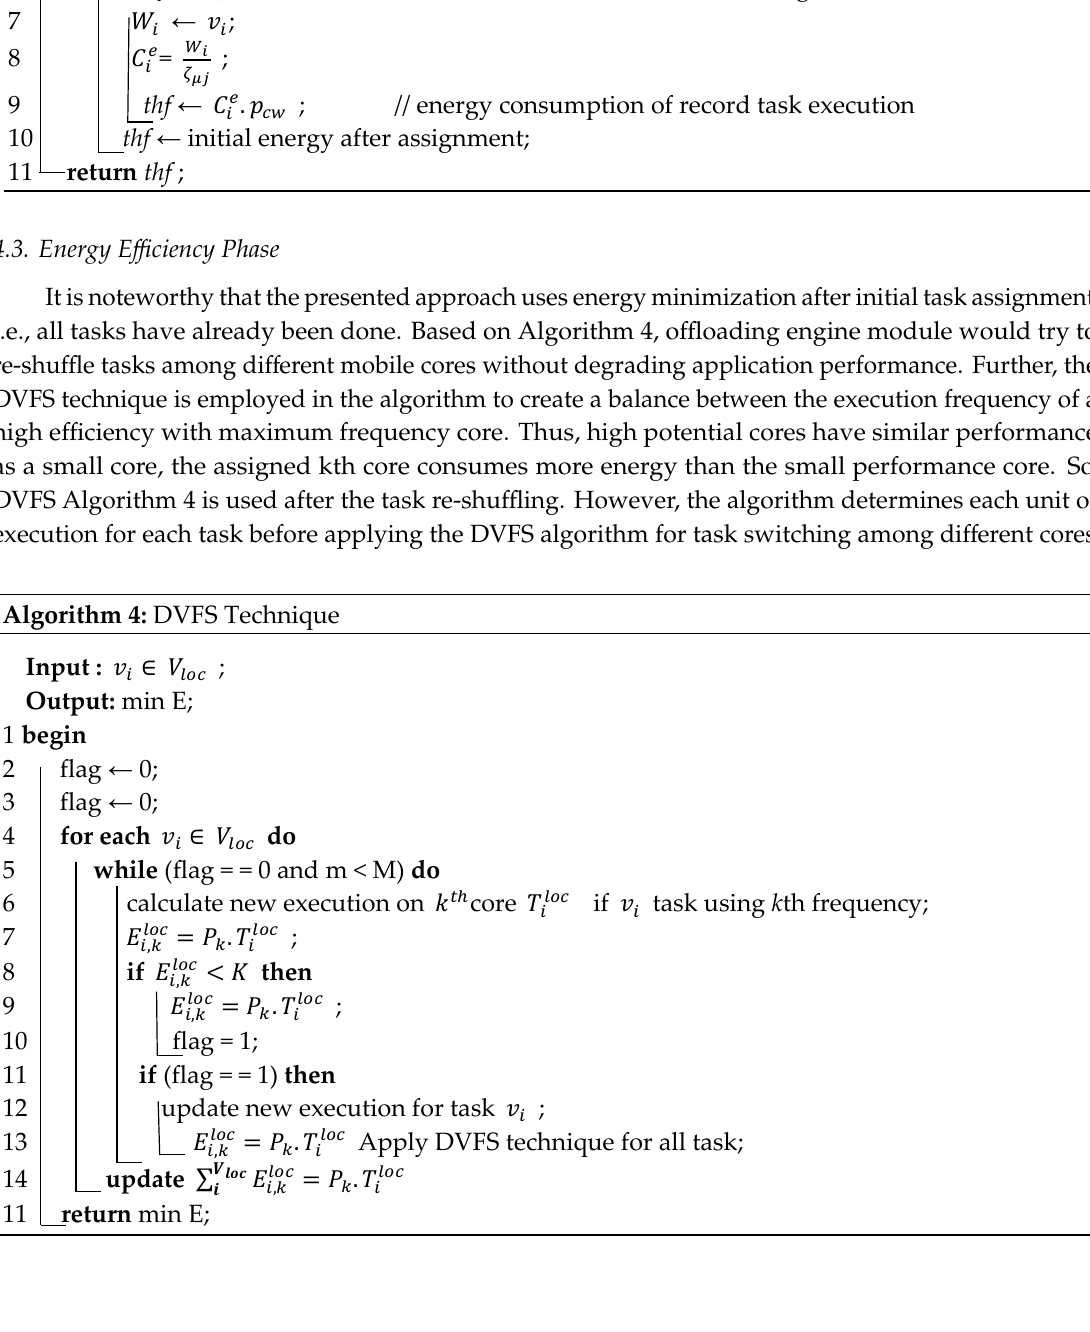
Table 2. Simulation parameters. Experiment